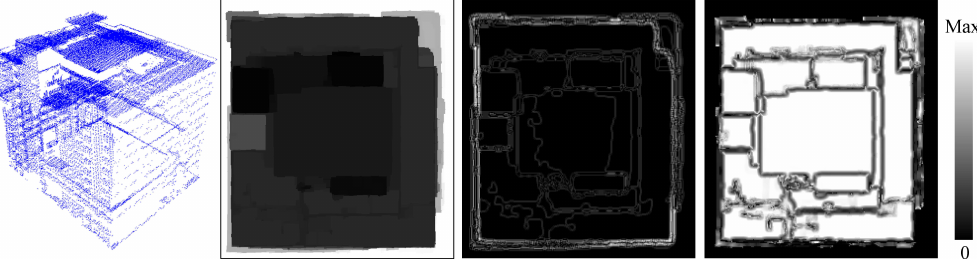
Figure 5. Results of geometric features. ( Left ): original point cloud; ( Right ): results of height, edge, and planarity features of the point cloud,